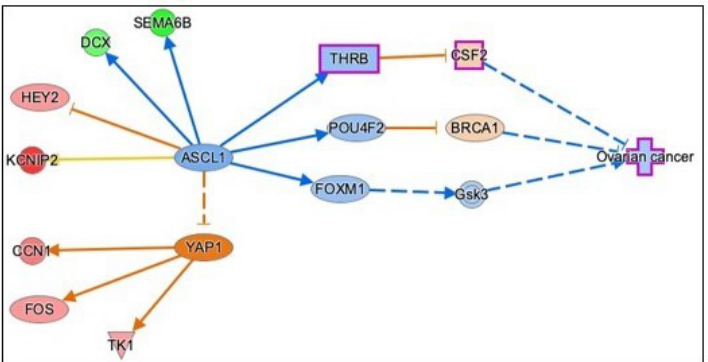
Figure 8. Effect of metformin on ovarian cancer as predicted by causal network analysis in IPA. Causal network analysis connects upstream regulators and dataset molecules in addition to IPA-knowledge- based literature to identify root regulators associated with ovarian cancer. ASCL1 is the master regulator predicted to be inhibited while YAP1 is predicted to be activated, due to downregulation of DCX and SEM6AB and upregulation of CCN1, FOS, and TK1, respectively. The key for the shape, color, direction and molecule types in the above pathways is provided in Figure